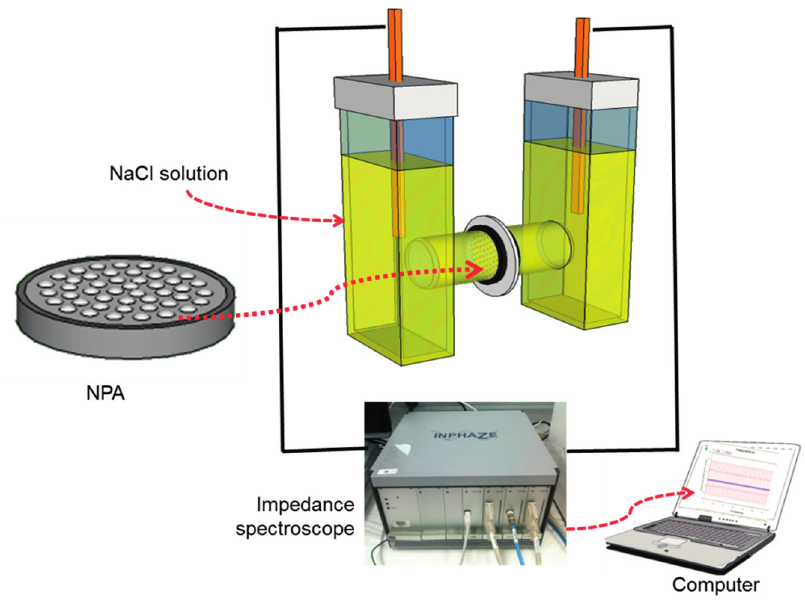
Figure 1. A schematic of experimental setup. The fabricated nano porous alumina (NPA) is sandwiched between two cells filled with electrolyte for two electrode EIS measurements of